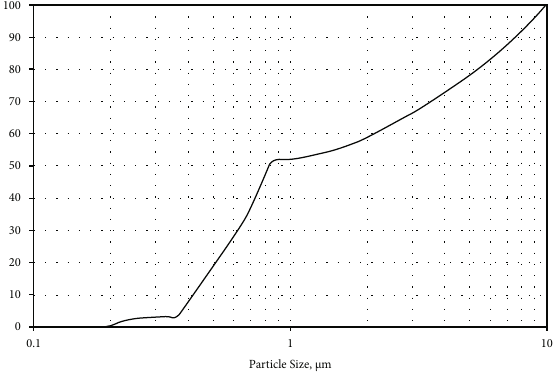
Figure 8: Cumulative screen analysis curve of biodiesel catalyst (CaO).